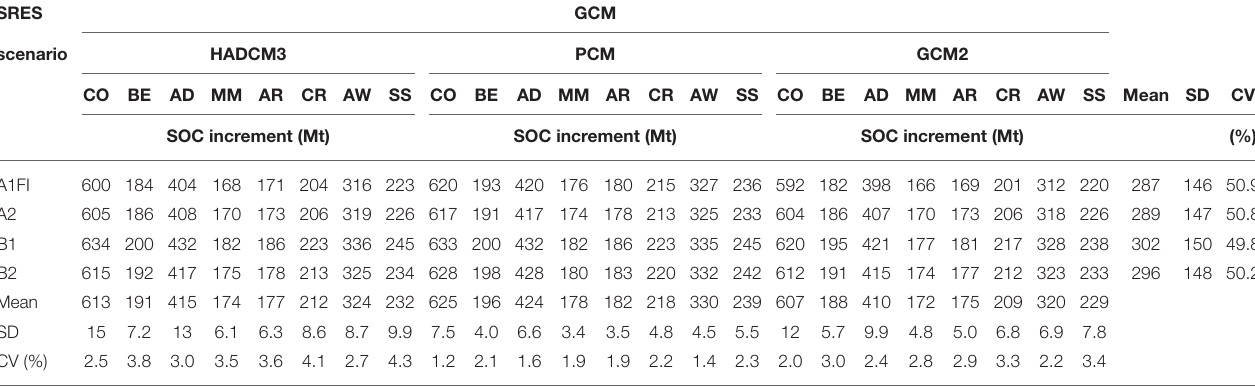
TABLE 4 | Modeled total SOC (Mt) increment in Italian agricultural soils amended for 100 years at a rate of 1t C ha − 1 y − 1 with different EOM groups and under different future climate scenarios. SRES GCM scenario